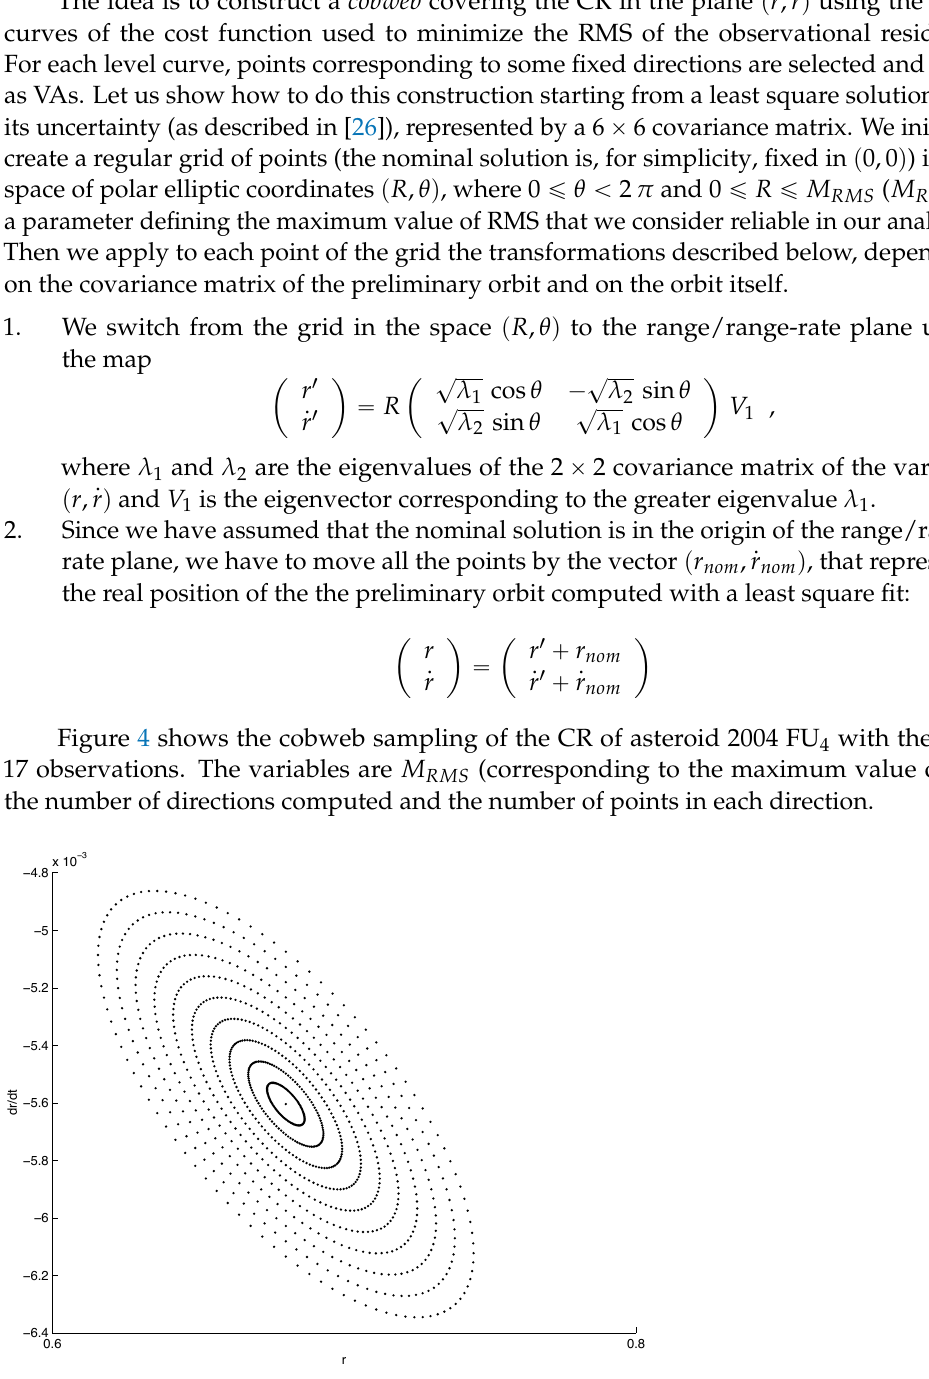
Figure 4. Asteroid 2004 FU 4 with the first 17 observations: CR in the p r , 9 r q plane, with maximum RMS equal to 4 and number of points equal to 1000 (100 directions and 10 points in each